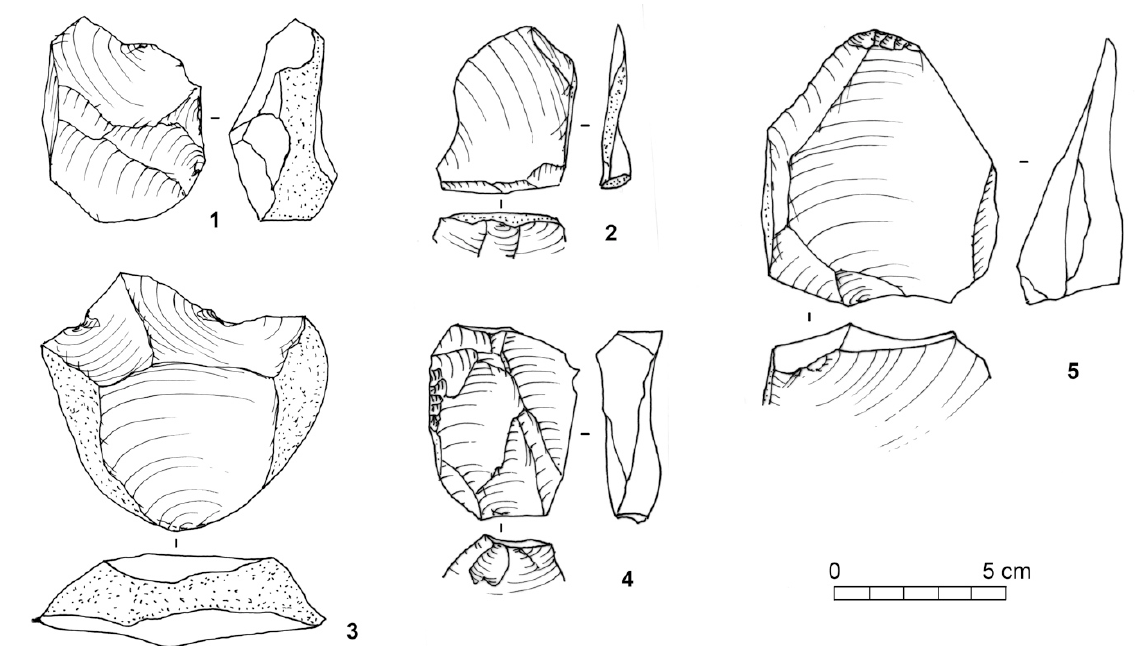
Figure 6. Flakes and flake tools from Square 1 of Tell Ghanem al-Ali. 1-2: part-cortex flakes; 3: retouched part- cortex flake; 4-5: retouched flakes (1: topsoil; 2: Levels 1-3; 3: Level 6; 4: Level 8; 5: Level